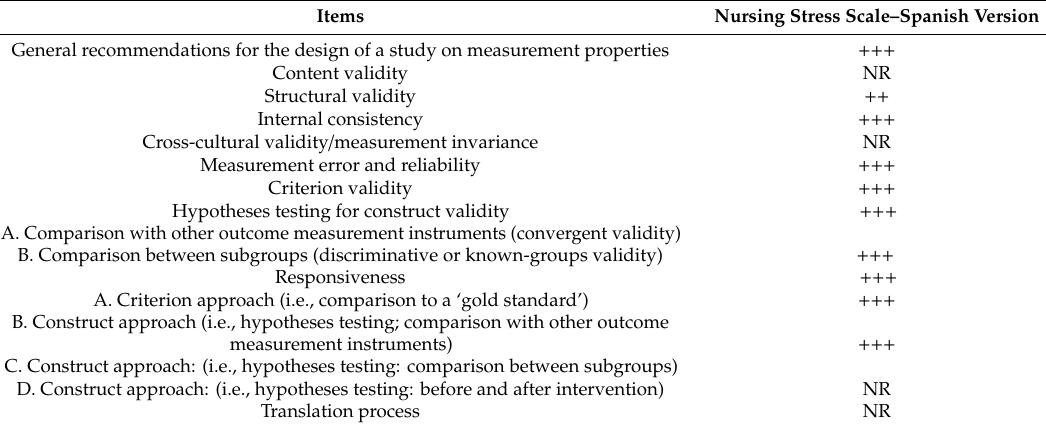
Table 4. Reporting Guideline Checklist. COSMIN